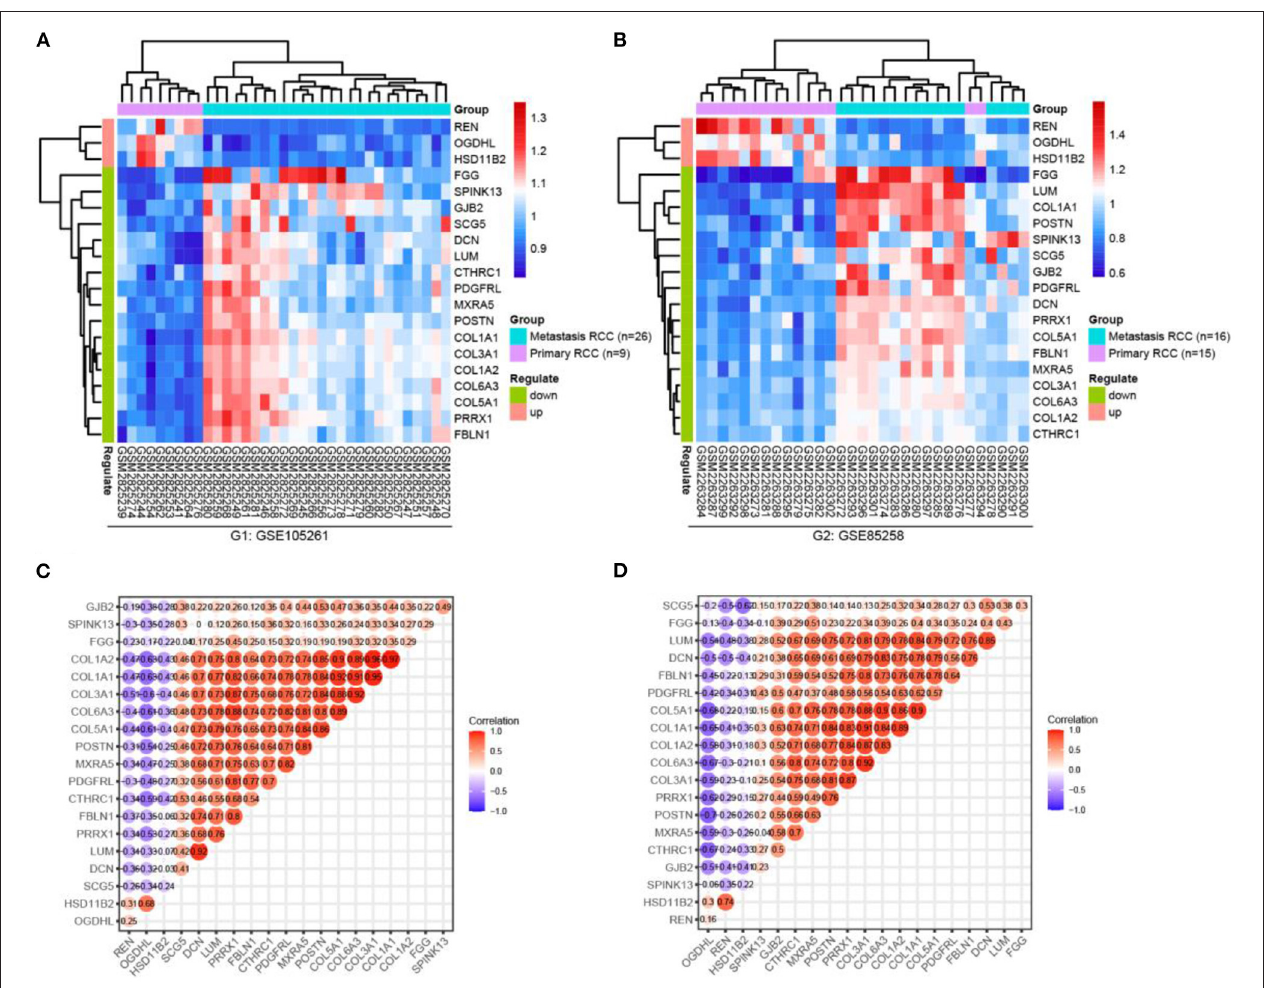
FIGURE 4 | Hierarchical clustering analysis and expression correlation calculation of mRNA expression of shared DEGs, which were compared primarily with the metastatic ccRCC group in the GSE105261 (A,C) and GSE85258 (B,D) datasets.